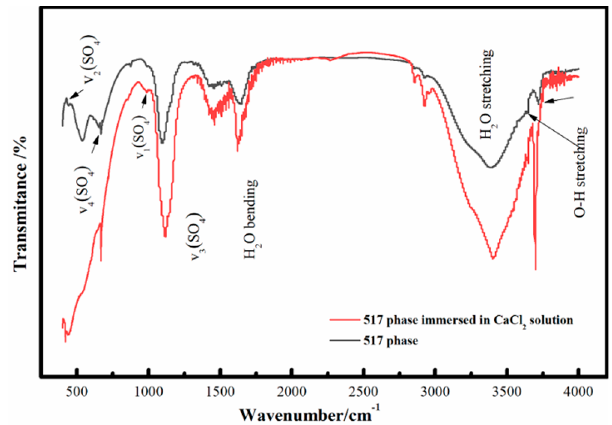
Figure 7. Infrared spectra of 517 phase before and after immersion of hardened paste in CaCl 2 solution.